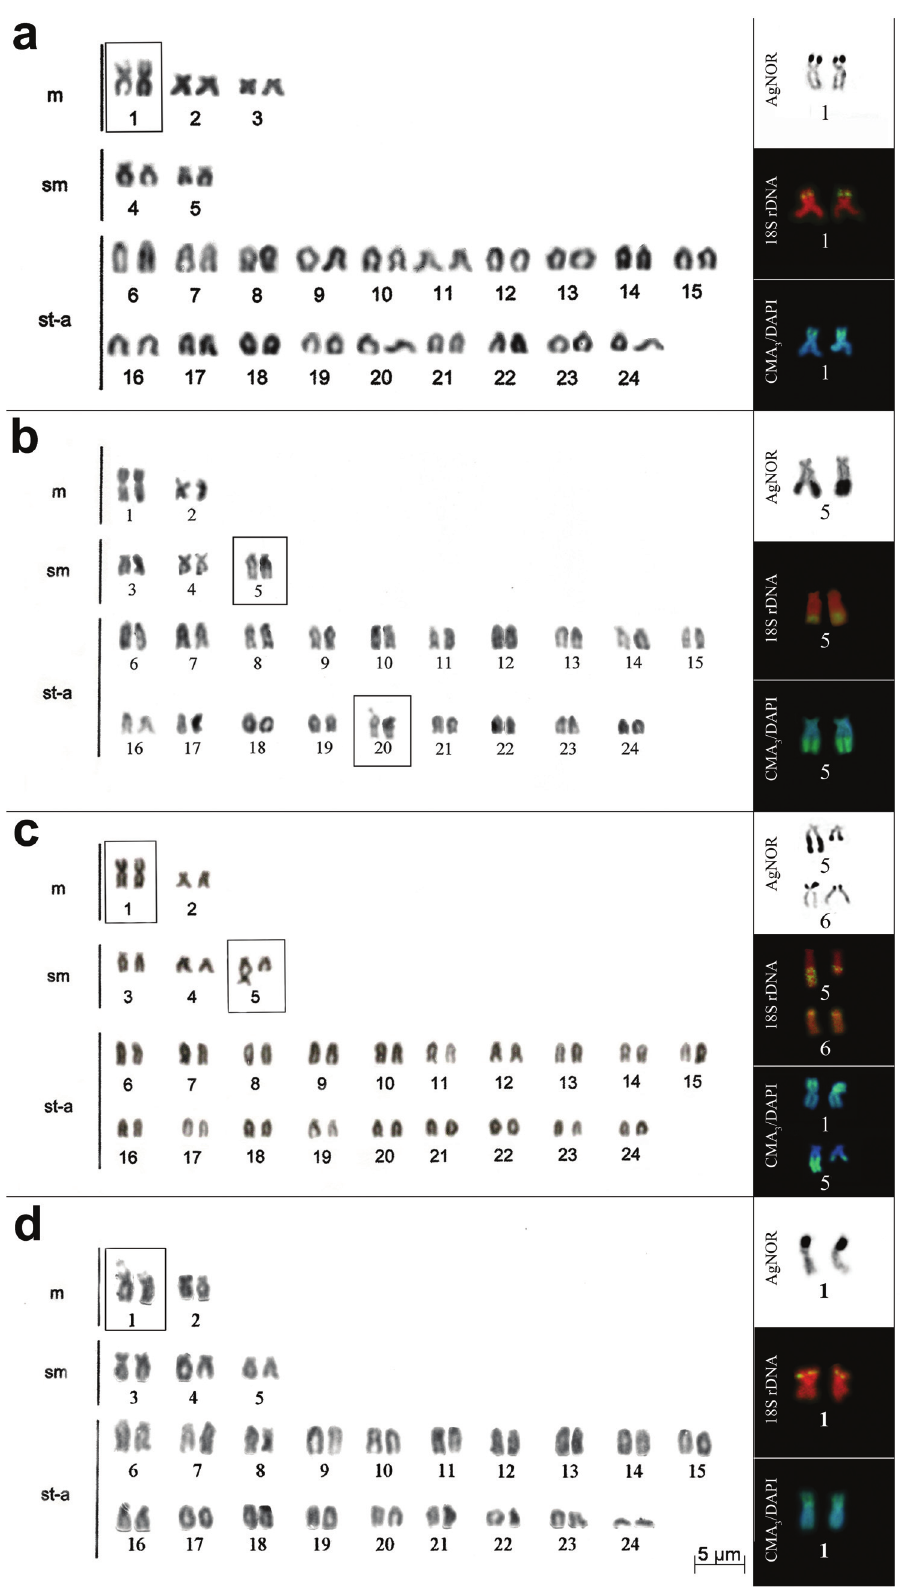
Figure 1 - Karyotype and chromosome pairs with silver nitrate staining, FISH with 18S rDNAr probe and CMA 3 /DAPI in: Crenicichla haroldoi (a), C. britskii , populations A (b) and B (c), and C. niederleinii (d), respectively. In the boxes are secondary interstitial constrictions in the short arm of the first metacentric pair (a, d) and in the long arm of the fifth pair (b,